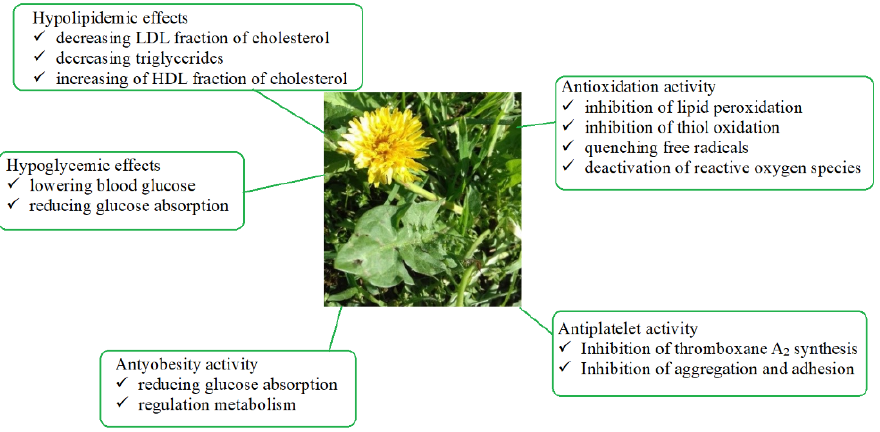
Figure 4. Multidirectional effects of dandelion and its preparations.